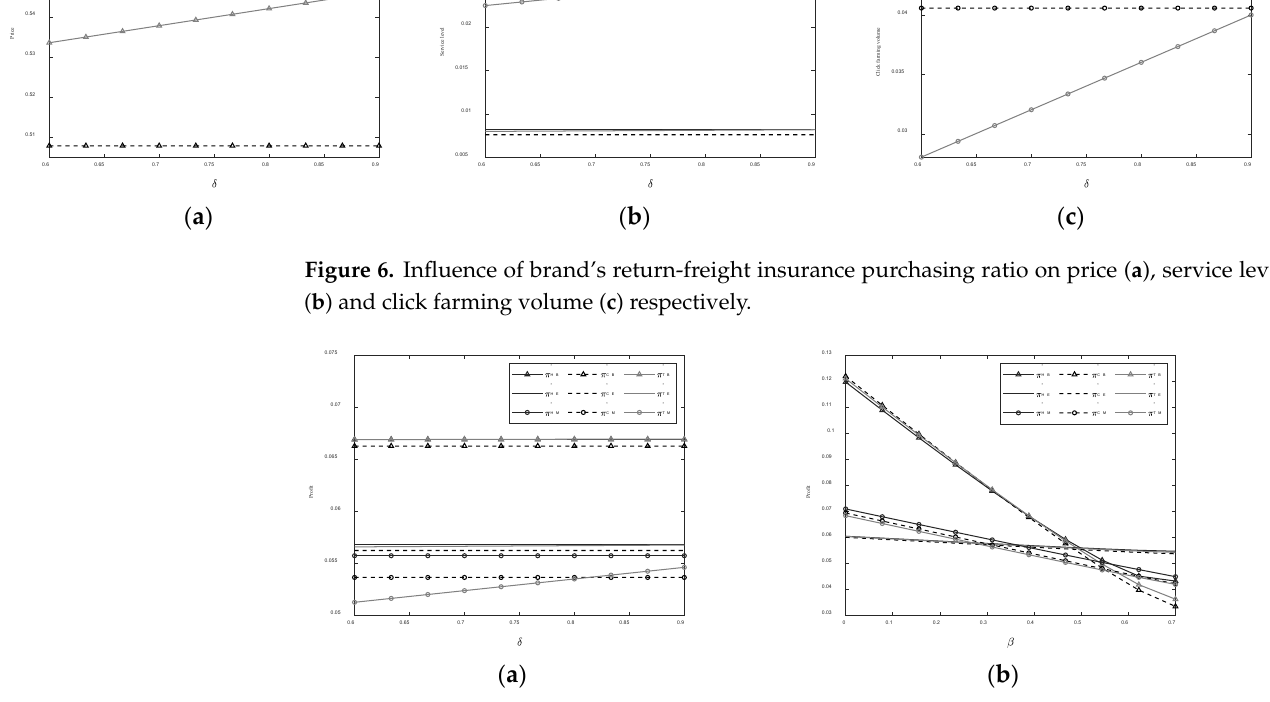
Figure 7. Influence of brand’s return-freight insurance purchasing ratio ( a ) and return rate ( b ) on the profits of brand respectively.